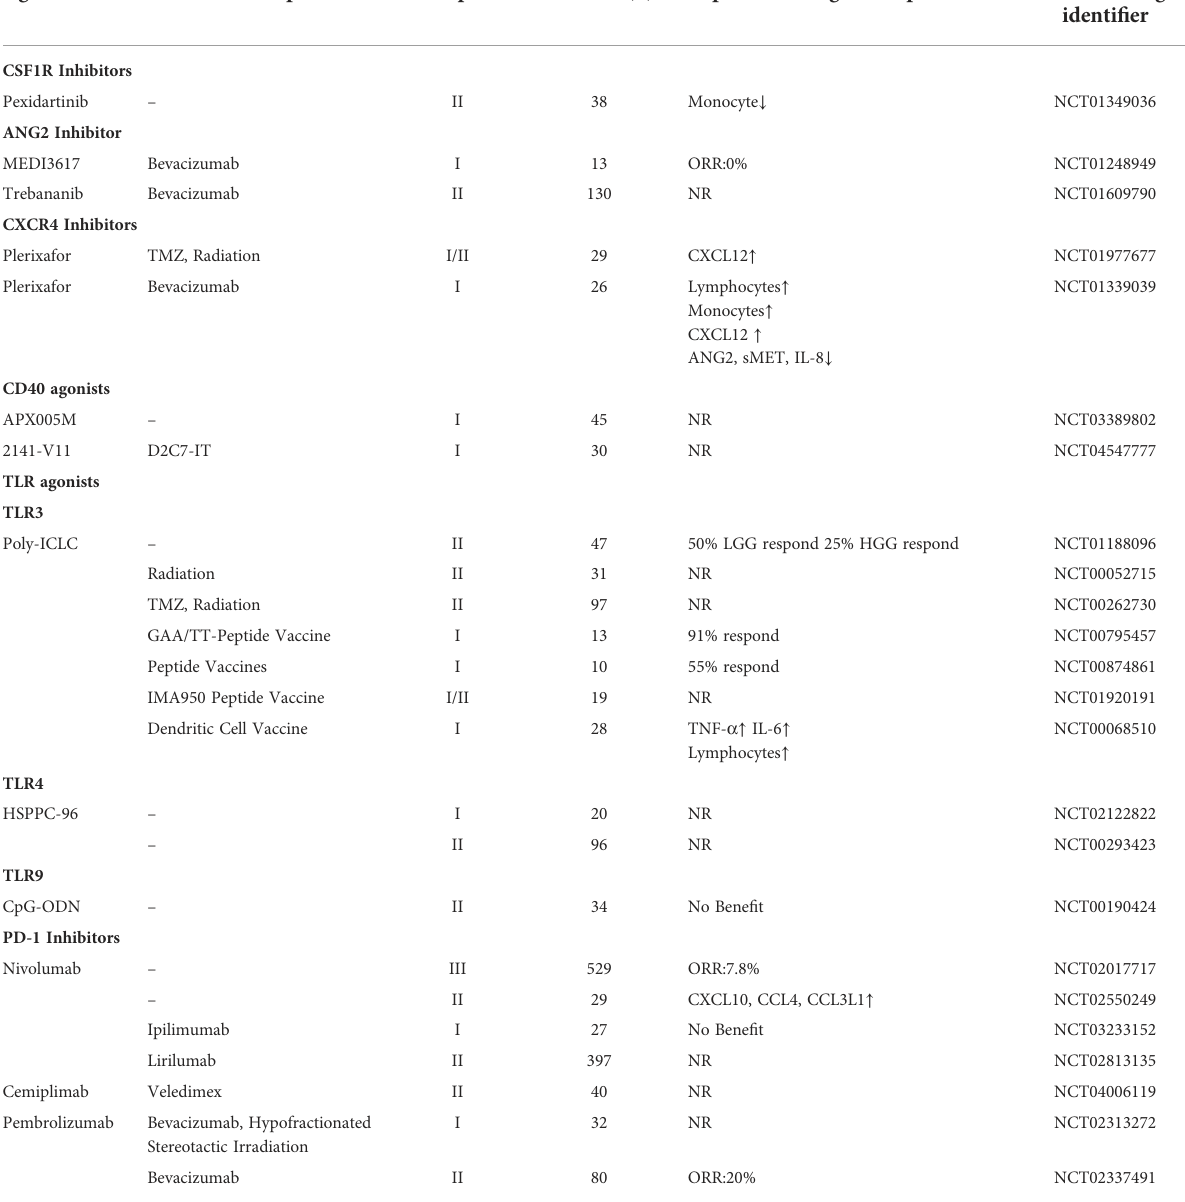
TABLE 1 The TAM-targeted clinical trials in